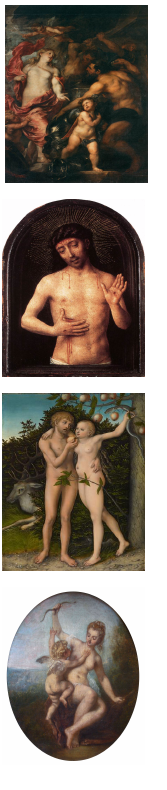
Figure 6. Examples from the WikiArt dataset with captions generated by models fine-tuned on the Iconclass, Flickr and COCO datasets.